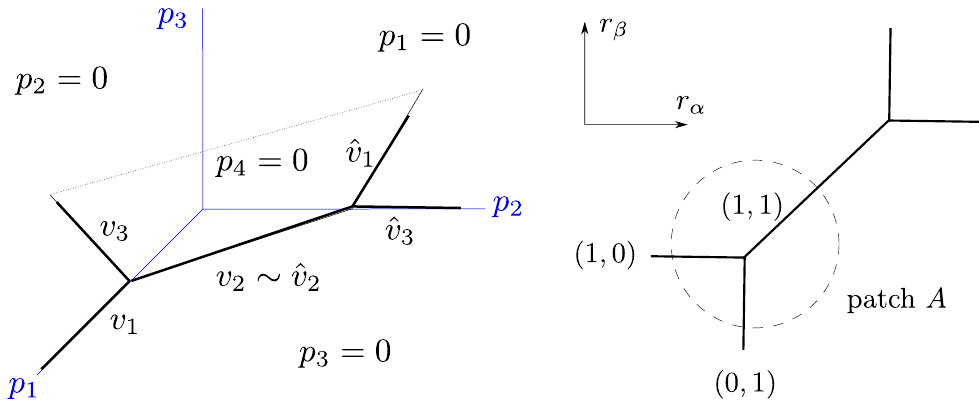
Figure 11 . Left: base of the T 3 (cid:12)bration for the conifold. Right: base for the T 2 (cid:2) R (cid:12)bration. Compared to the previous discussion, a salient novelty that emerges from the geometry of toric threefolds is the 3d nature of twin plane partitions. From the algebraic viewpoint, the relations P h = 0 (and the hatted counterpart) e(cid:11)ectively reduce the description of i i 3d plane partitions to two dimensions. On the other hand, toric geometry o(cid:11)ers a natural 3d perspective, which arises from changing the choice of (cid:12)bration from T 2 (cid:2) R to T 3